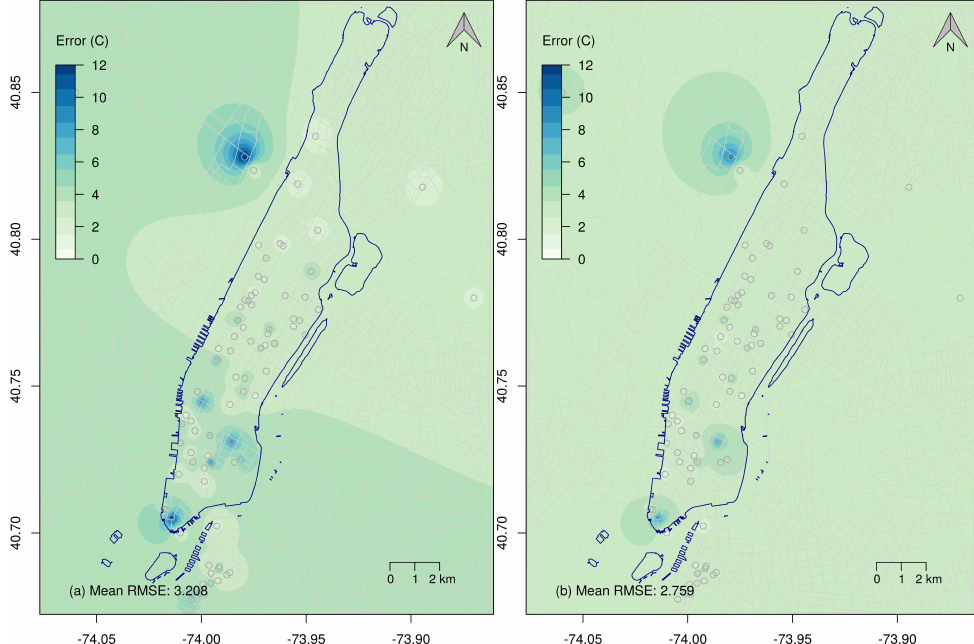
Figure 8. Downscaled prediction error map—The figure shows the spatial representation of the RMSE of NAM-NMM and AnEn as a function of lead times; the ( a ) map on the left shows the mean spatial error calculated over the entire test period between PWSs and NAM-NMM, while the ( b ) map on the right shows the mean spatial error between PWSs and the